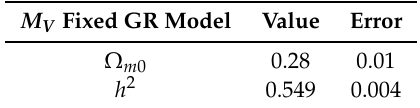
Table 3. Fitted parameters using MCMC for